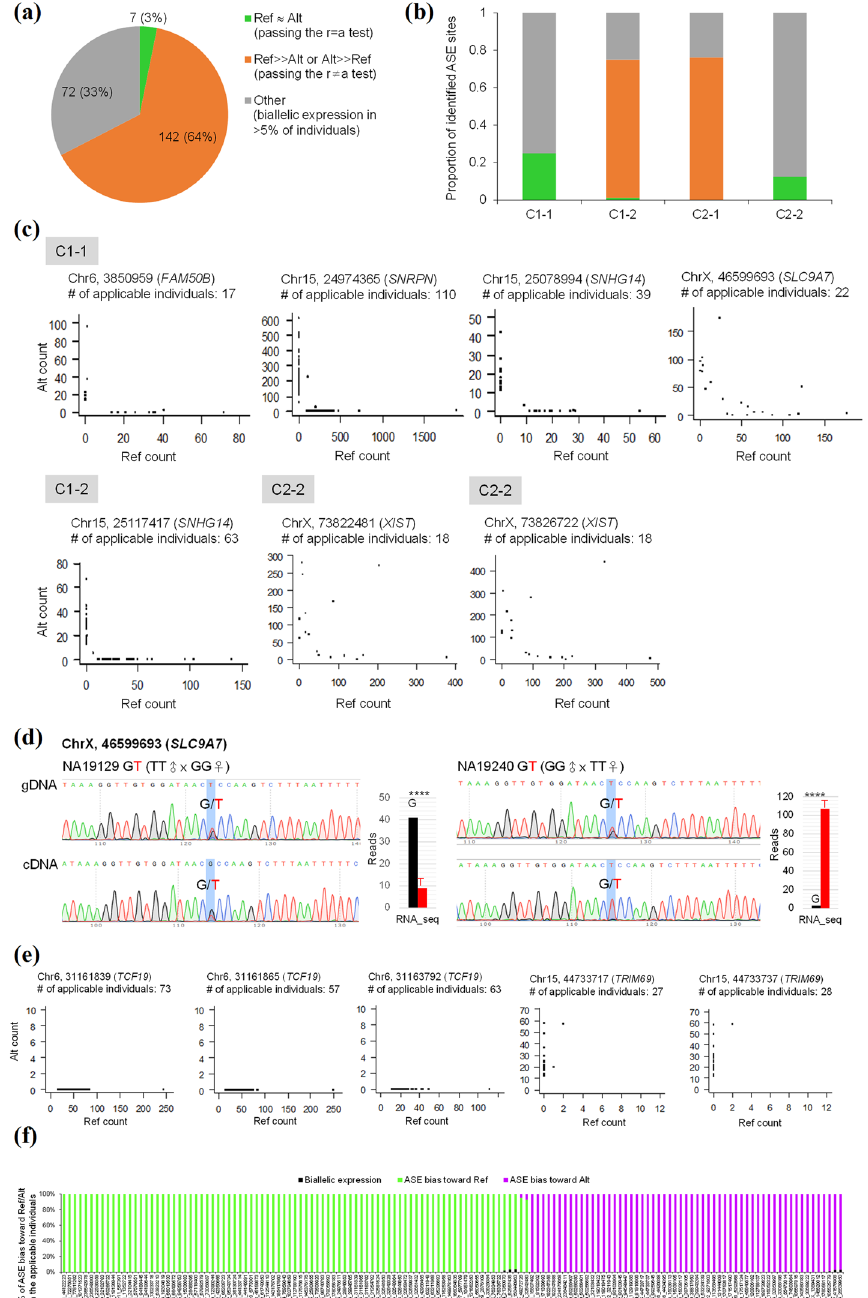
Figure 4. Population-scale analysis of the four categories of ASE in the Geuvadis LCL dataset. ( a and b ) Distribution of ASE variants passing the r = a test, ASE variants passing the r ≠ a test, and other ASE variants in ( a ) the total identified ASE variants and ( b ) the four categories of ASE. ( c ) Population-scale allelic expression patterns for the eight ASE variants passing the r = a test (five in Category 1-1, one in Category 1-2, and two in Category 2-2). Each plot depict represents the reference vs. alternative allele read counts for a SNP across all applicable individuals. A dot represents a SNP in an applicable individual. ( d ) Validation of the imprinting status of the newly identified imprinted gene ( SLC9A7 ). Shown in the figure were the Sanger-sequencing results of SLC9A7 with genomic DNA (gDNA) and cDNA from NA19129 and NA19240, which exhibited maternal expression with the RAD pattern between NA12878 and NA19240. Bases were colored as: A, green; C, blue; G, black; T, red. Significant differences between the paternally expressed read count and the maternally expressed read count (from the RNA-seq data) were evaluated using the Chi -square test. **** P < 0.0001. ( e ) Examples of population-scale allelic expression patterns for the ASE variants passing the r ≠ a test. ( f ) Distribution of ASE bias toward the reference allele, ASE bias toward the alternative allele, and biallelic expression in the applicable individuals for each ASE variant passing the r ≠ a test. A high-resolution figure (Fig. 4f) is provided in Dataset 1. Ref, the reference allele. Alt, the alternative